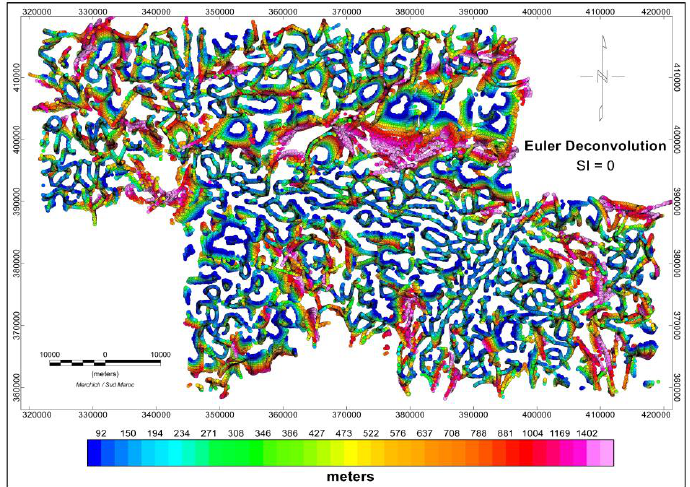
Figure 18. Euler deconvolution map for SI = 0.